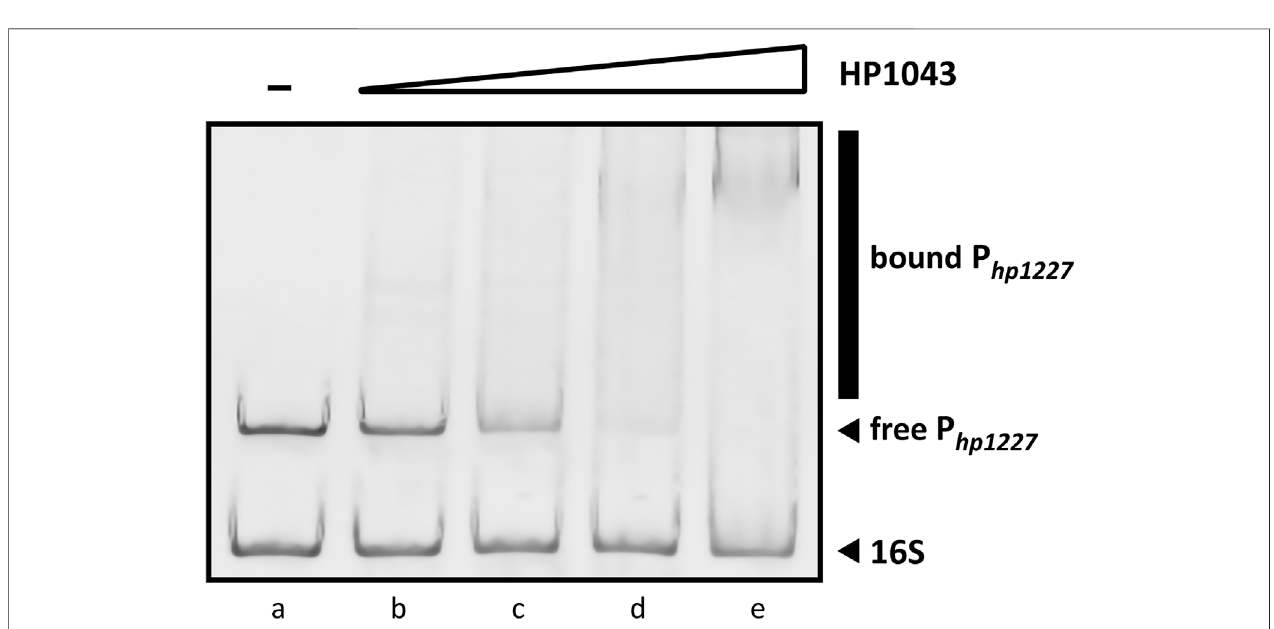
FIGURE7| Titration ofthe190-bp speci fi cDNAprobewithHP1043. AllsamplescontainedtwoDNAprobes,onespeci fi c(P hp1227 )andanothernon-speci fi c(16S rRNA gene).Foreach reaction, 10 ng ofeach DNA probe wasused. Lane (a) control reaction without HP1043 protein; lane(b) to(e) samples containing, respectively,1, 2, 4, and 8 μ M of HP1043 protein. DNA probes were mixed with increasing concentrations of the recombinant protein, incubated at room temperature for 30 min, and subjected toa 6% PAGE.EMSAanalysisshow a decrease infreeprobe (P hp1227 ) in response toincreasingamounts ofHP1043 protein, indicative ofthe formation of speci fi c protein – DNA complexes represented by a smear (marked with a vertical line on the right side of the image). The smear represents protein – DNA complexes dissociating during